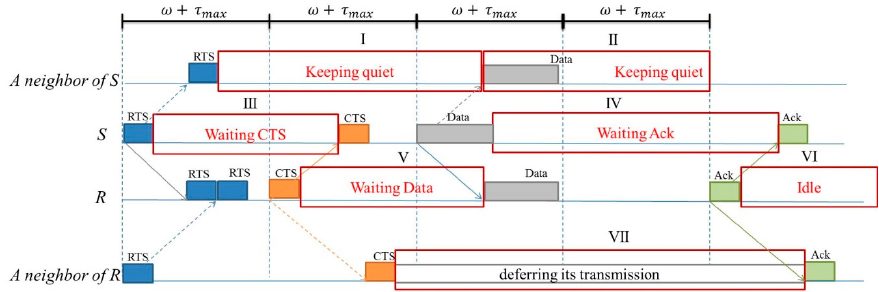
Figure 2. Wait periods that can be utilized in underwater transmissions.